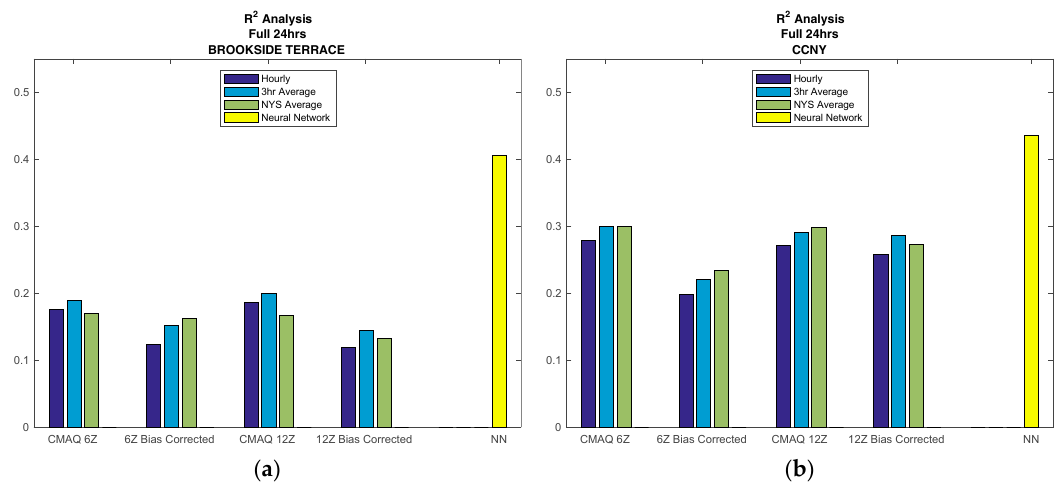
Figure 5. Regression analysis is computed for the comparison between AirNow observations and the various prediction models, for the complete CMAQ database time period (February 2016, through October 2016). The R 2 value for each model is plotted in the figure above to compare CMAQ to the NN. The CMAQ model includes the different release times as well as bias compensated vs. uncompensated runs. In addition, different time and spatial averaging of CMAQ is considered at each location. ( a ) Brookside Terrace, representative of non-NYC; ( b ) CCNY, representative of NYC.